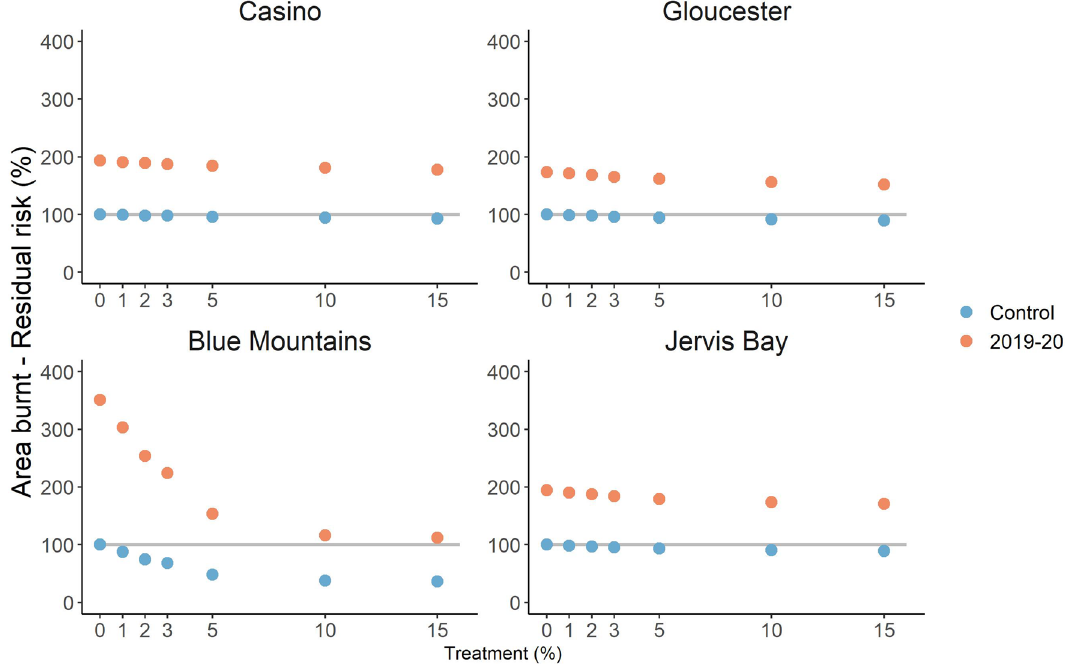
Figure 3.. Residual risk trajectory of area burnt by wildfire in Casino, Gloucester, Blue Mountains and Jervis Bay. Risk is relative to a scenario with no prescribed burning and long-term weather (the 100% level on the y-axis). Markers represent different annual rates of treatment, colours represent different weather conditions (blue = control i.e. long-term, orange = 2019–2020 fire